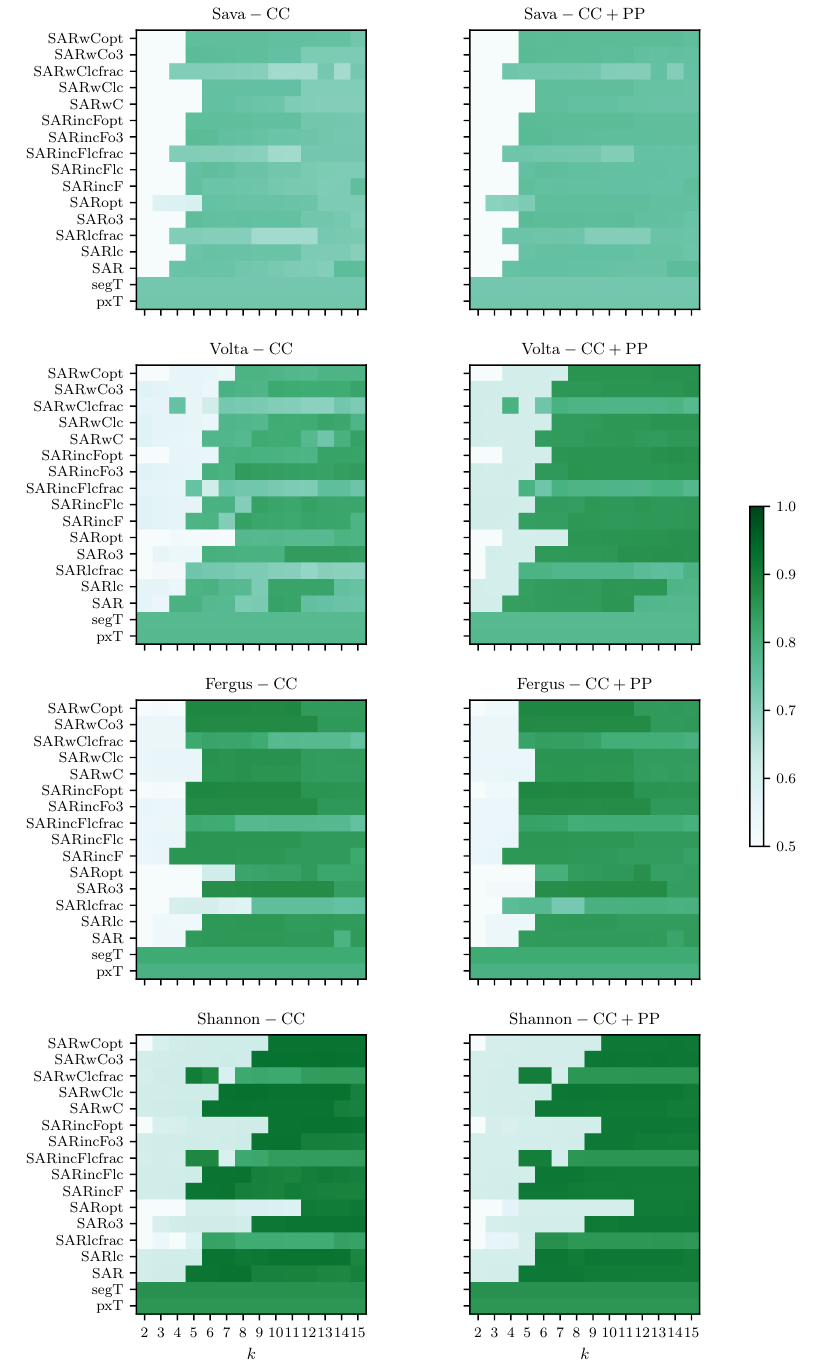
Figure 4. Three-class F1 scores for K-means clustering and cluster classification (CC, left ) and K-means clustering and cluster classification, complemented by the post-processing refinement, (CC+PP, right ), using different feature spaces and a varying number of clusters k